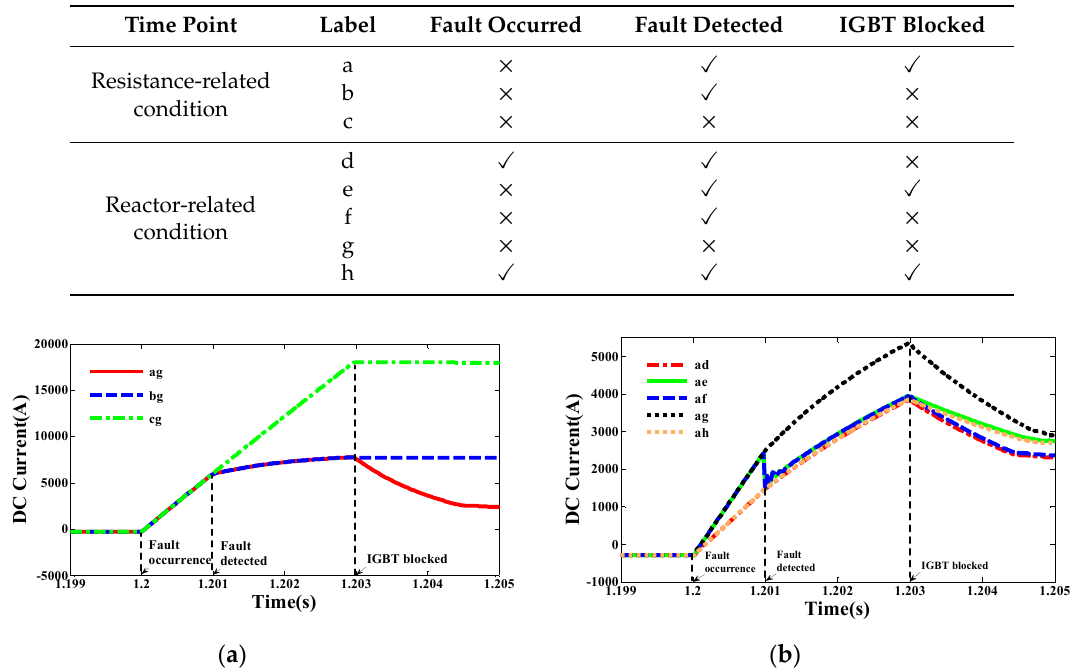
Figure 12. Comparison among different FCL schemes ( a ) different resistance conditions without considering the reactor, ( b ) different reactor conditions with selected resistance schemes. Table 2. Condition classification for the fault current limiting circuit scheme.